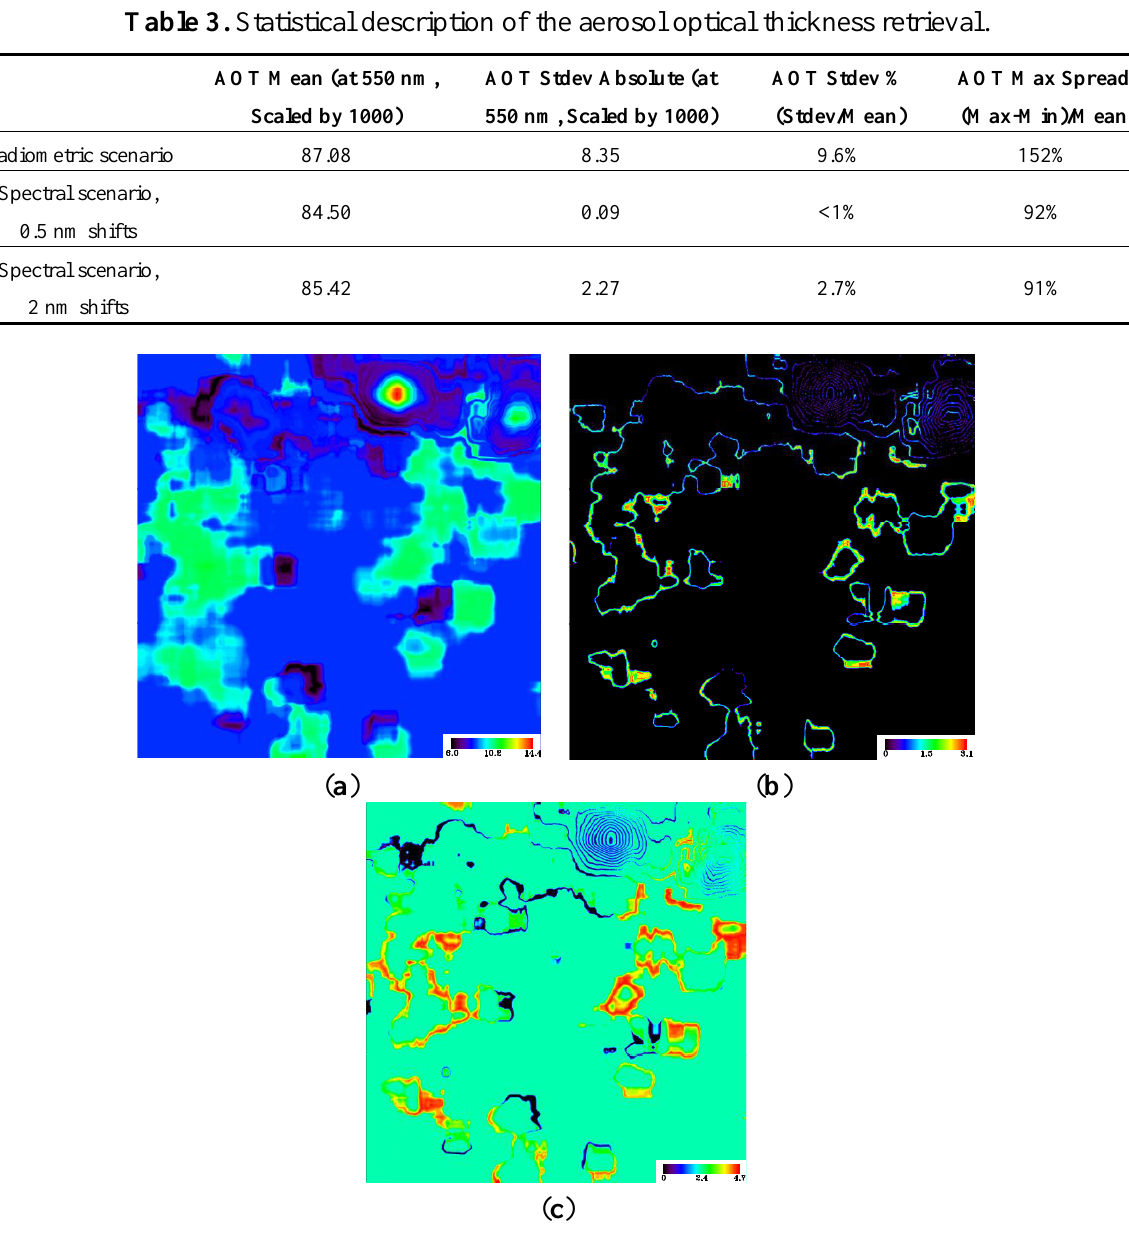
Figure 18. Standard deviation calculated over all AOT maps; ( a , top-left) radiometric scenario; ( b , top-right) 0.5 nm shift scenario; ( c , bottom-left) 2 nm shift scenario. Note that the data range and thus the colour coding is different for each